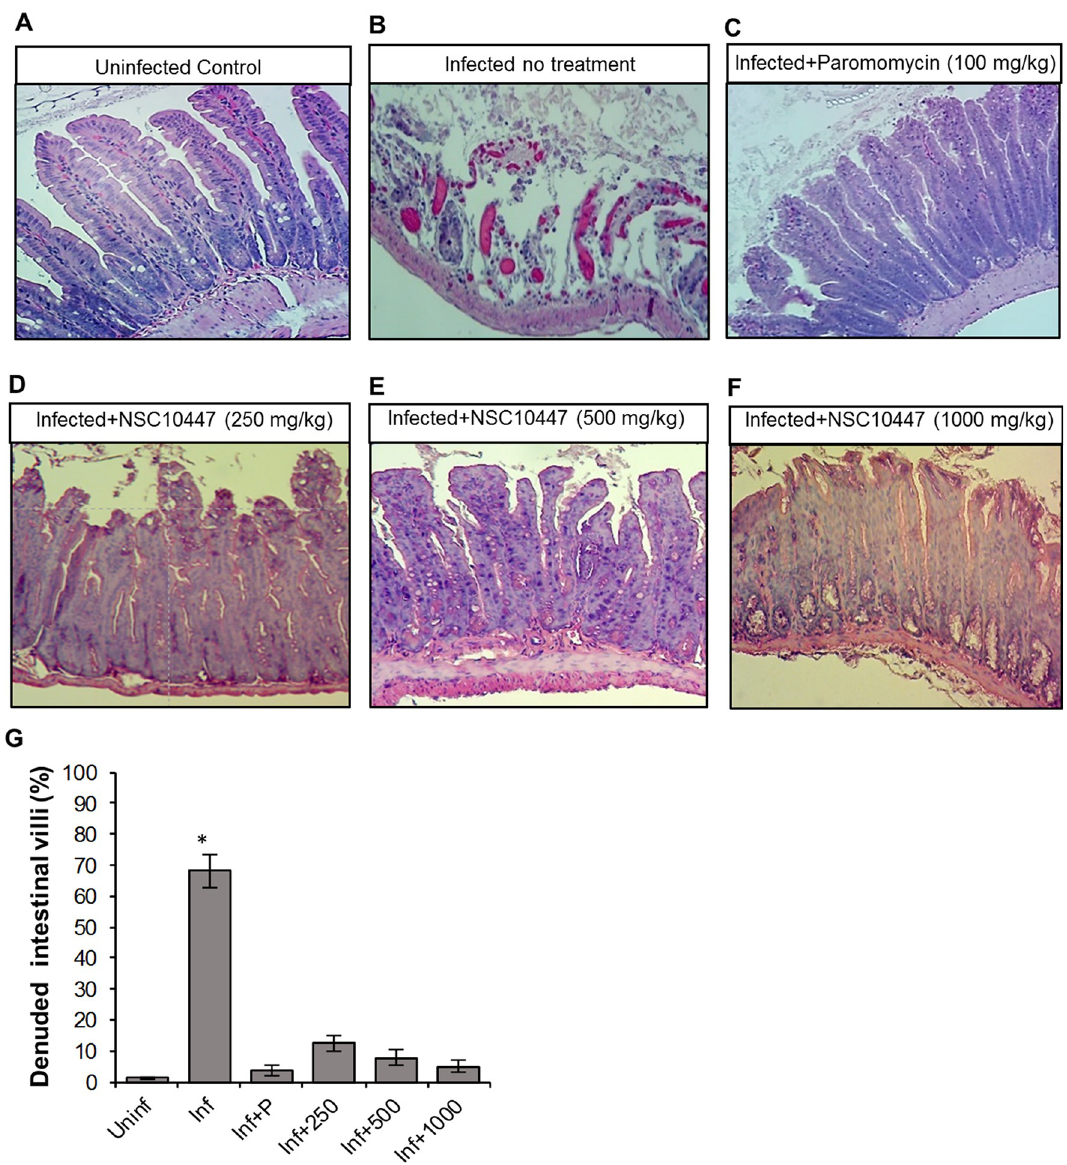
Fig 8. Histopathological analysis of the effect of Cryptosporidium parvum infection in the lower small intestines of mice with or without NSC10447 treatment. Mice infected with C . parvum were maintained untreated (Infected no treatment), treated with paromocycin at 100 mg/kg (Infected+Paromomycin (100 mg/kg)) or treated with compound NSC10447 (Infected+NSC10447) at varying doses (250, 500 or 1000 mg/kg) for 8 days. Uninfected mice were maintained as control (Uninfected Control). After 8 days, mice were sacrificed and the lower intestinal tissue processed for histology, and stained with hematoxylin and eosin. (A) Uninfected control mice samples depicted intact intestinal epithelium with prominent villi. (B) In contrast, infected mice without treatment depicted denuded villi. Infected mice treated with (C) 100 mg/kg Paromomycin, (D) 250 mg/kg NSC10447, (E) 500 mg/kg NSC10447, and (F) 1000 mg/kg NSC10447 depicted intact intestinal epithelium with prominent villi that were comparable to the uninfected control. The images are representative of samples analyzed from 3 mice per treatment group. (G) The mean percentage of denuded villi in 4 randomly chosen microscopic fields per sample from the uninfected (Uninf), infected untreated (Inf), infected treated with 100 mg/kg paromomycin (Inf+P), infected treated with 250 mg/kg NSC10447 (Inf+250), infected treated with 500 mg/kg NSC10447 (Inf+500), and infected treated with 1000 mg/kg NSC10447 (Inf+1000) mice. The data shown represent means for samples from 3 mice per group with standard error bars and levels of statistical significance depicted ( � P < 0.05).